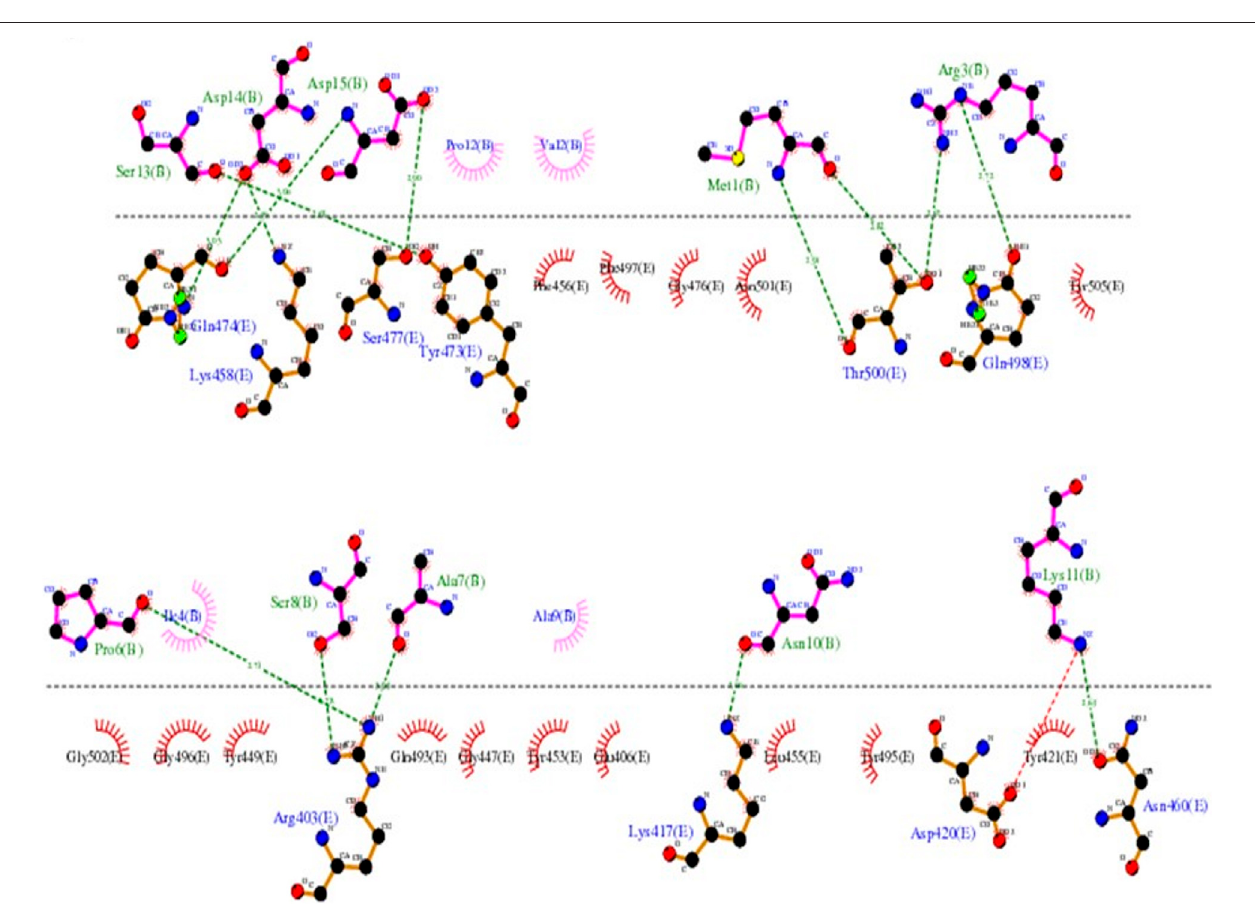
FIGURE 2 | The LIGPLOT diagram of protein-peptide interaction between the RBD and SPIKENET. The pink color SPIKENET peptide residues are shown on the top and yellow color amino acid residues of the RBD from SARS-CoV- two are shown at the bottom. The SPIKENET peptide consists of 15 amino acid residues, 14 of which are shown in non-bonded interactions with the RBD of SARS-CoV-2, which proves that SPIKENET has a signi fi cant binding af fi nity with the spike glycoprotein-1. These fi ndings strongly suggest that SPIKENET is a potent competitive inhibitor of